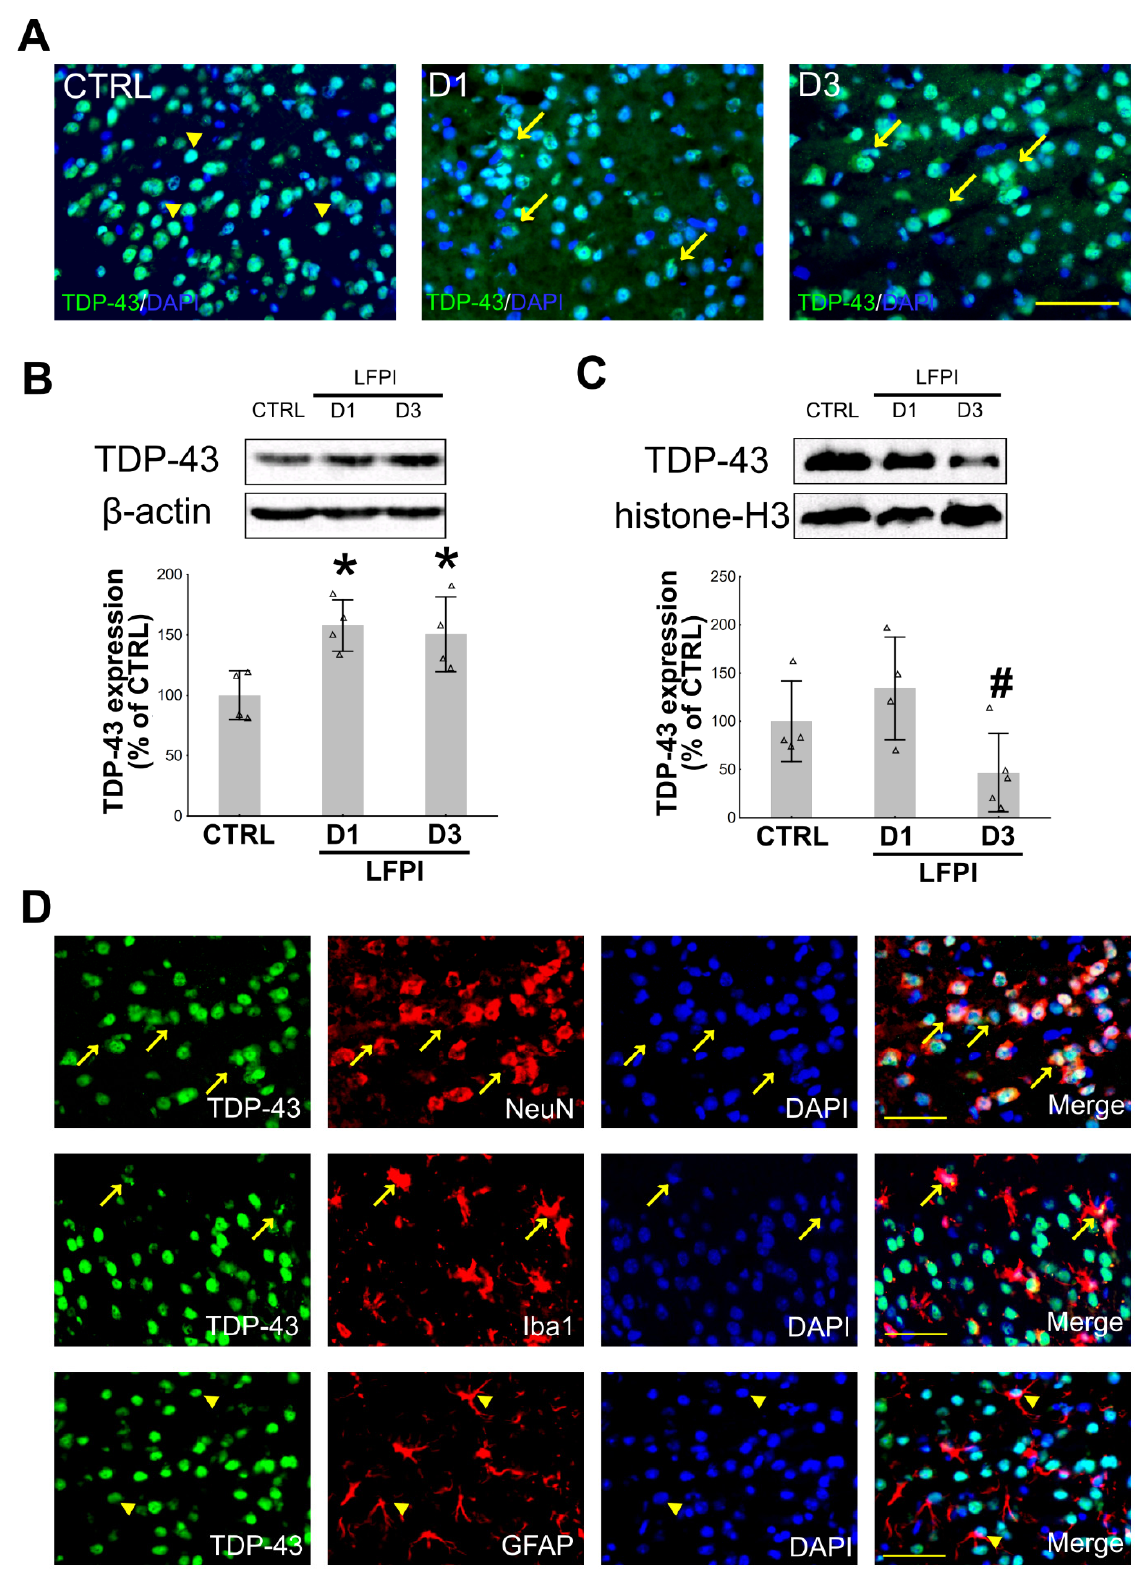
Figure 1. Subcellular localization of transactive response (TAR) DNA binding protein 43 (TDP-43) in the mouse ipsilateral cortices 1 and 3 d after a single lateral fluid percussion injury (LFPI): ( A ) Representative microphotographs show TDP-43- immunostained (green) sections, counterstained with DAPI nuclear stain (blue) in the animal of the control group (CTRL), sacrificed 1 day after the experimental procedures, and the mice with LFPI sacrificed 1 (D1) or 3 (D3) d following single moderate LFPI. Arrowheads point to cells with predominant nuclear staining, and arrows point to cells with pronounced